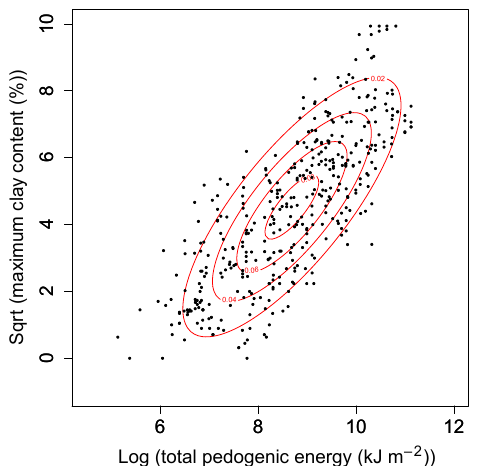
Figure 4. Bivariate normal distribution between TPE and max clay content. The points indicate individual soils. The red ellipses rep- resent lines of equal probability, which corresponds to a three- dimensional probability distribution. From this relationship the con- ditional mean and variances for the soil physical properties were